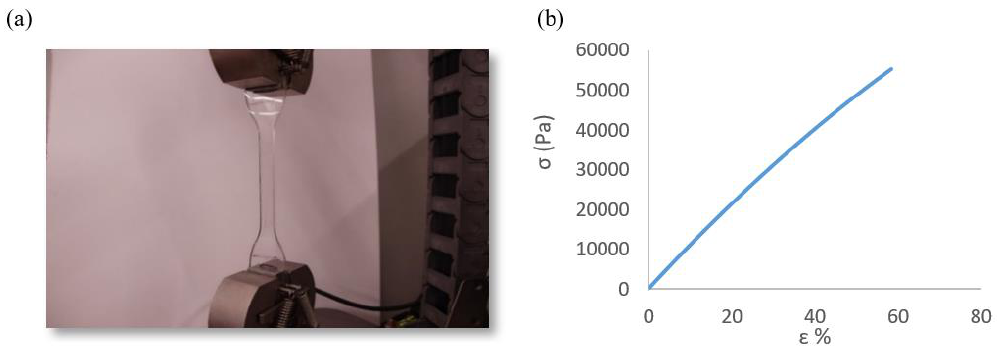
Figure 2. ( a ) specimen positioned on the tensile machine. ( b ) PDMS stress-strain curve.